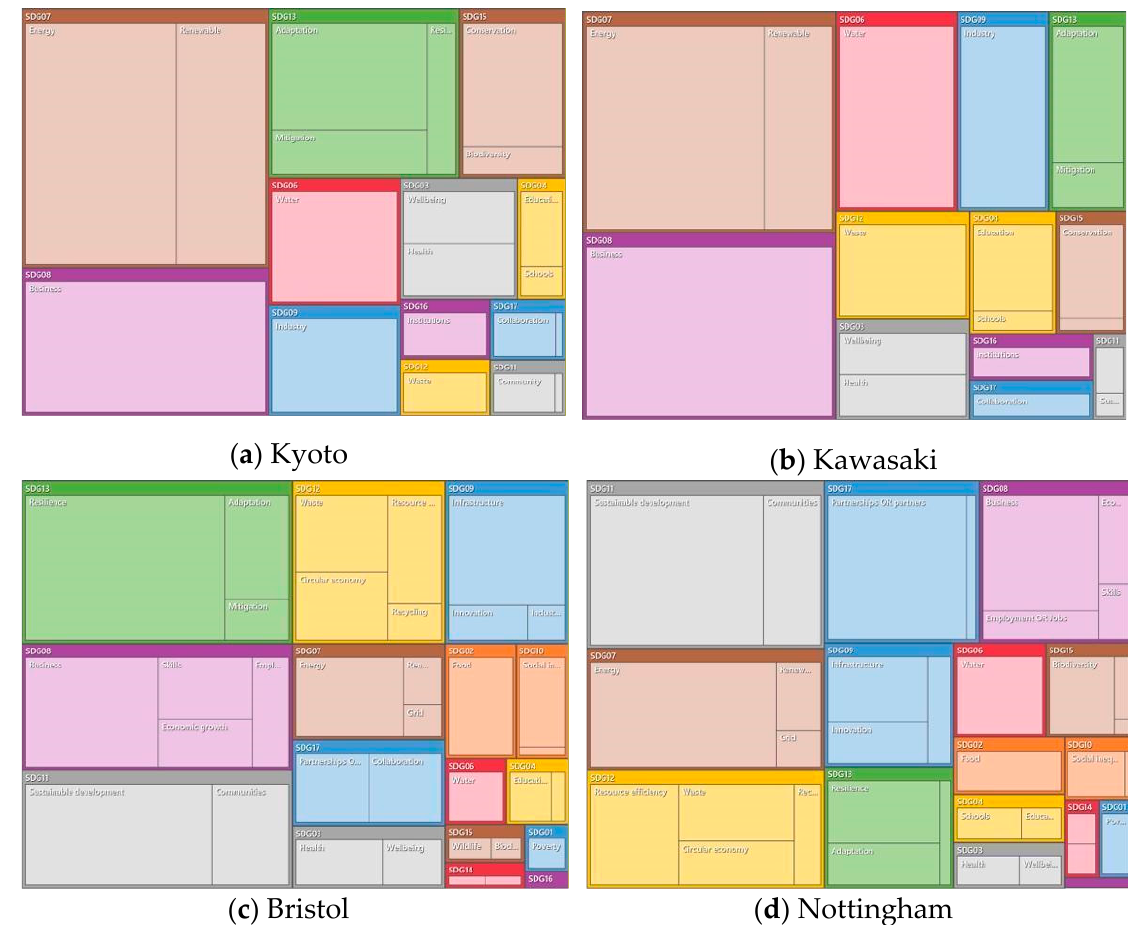
Figure 2. Hierarchy charts comparing prominence of SDGs in selected Japan and UK cities: ( a ) Kyoto; ( b ) Kasawaki; ( c ) Bristol’ and ( d ) Nottingham.